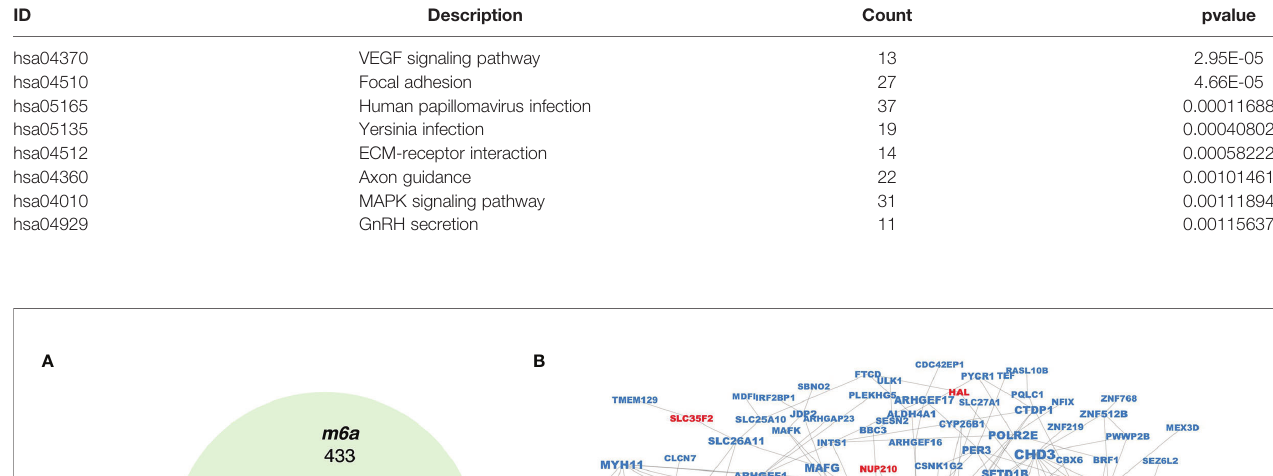
TABLE 4 | Functional enrichment of m6a regulatory networks.